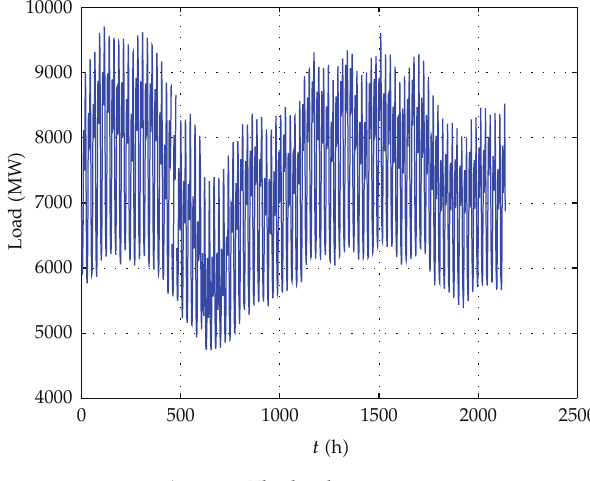
Figure 3: The load time